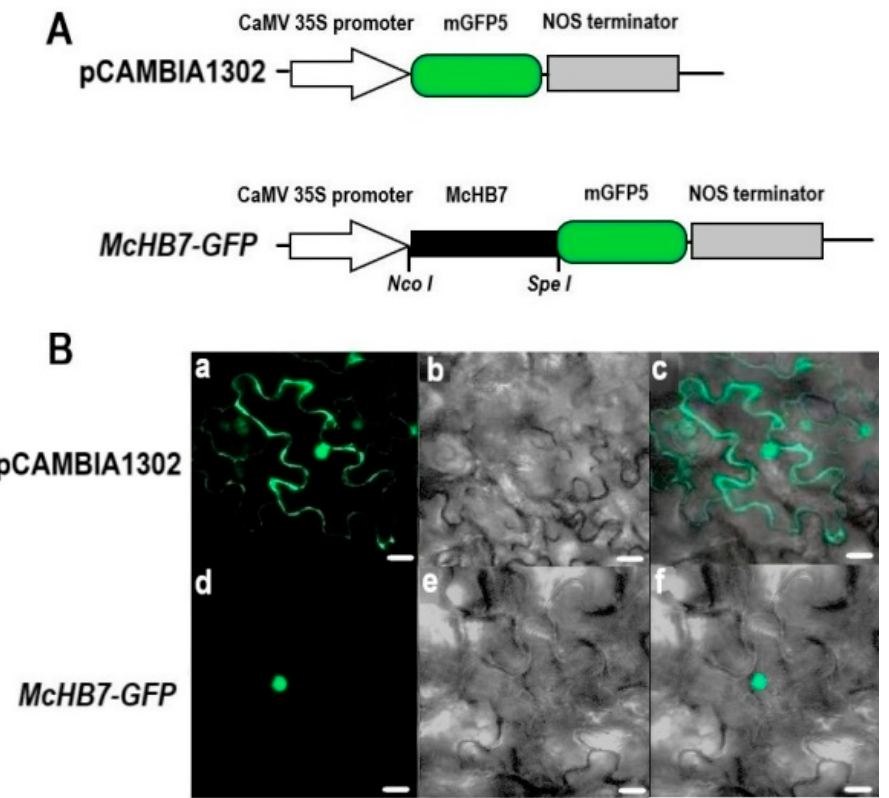
Figure 2. Subcellular localization of Mc HB7 protein. ( A ) Schematic maps of the positive control pCAMBIA1302-GFP and the Mc HB7-GFP construct in the pCAMBIA1302vector. ( B ) The McHB7- GFP fusion construct and the positive control pCAMBIA1302were introduced into tobacco leaves by infiltration. GFP fluorescence was observed by confocal laser scanning microscopy. ( a ) and ( d )fluorescence images observed in a dark field (green); ( b ) and ( e ) light images observed in bright field; ( c ) and ( f ) merged images of dark field and bright field. Scale bar = 30 μ m.